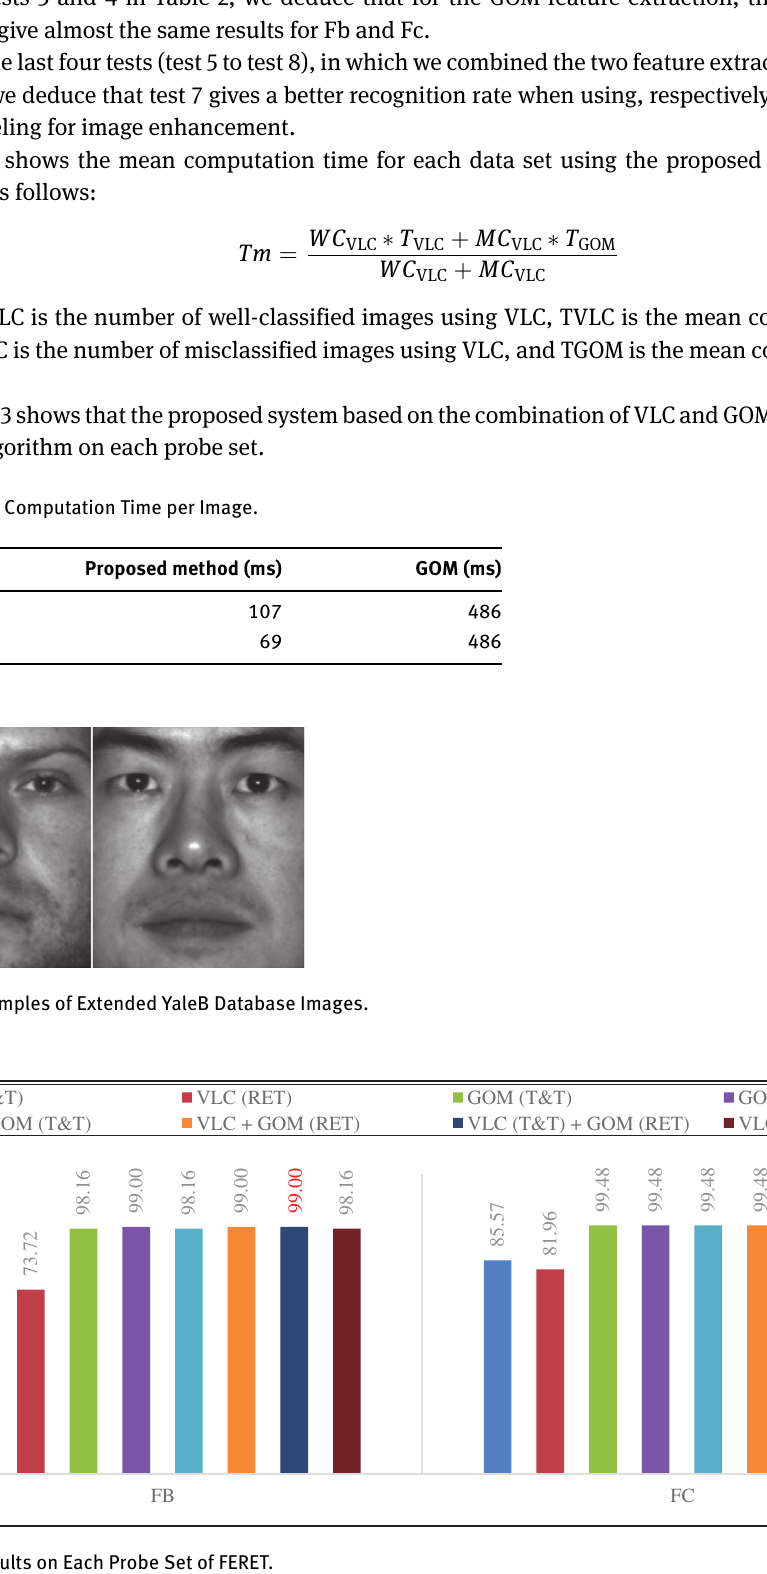
Figure 14: Results on Each Probe Set of